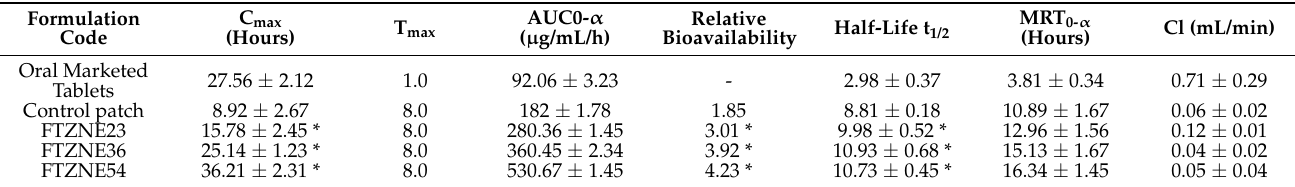
Table A7. Pharmacokinetic parameters of Tizanidine administered orally and transdermal on rabbits, n = 3, mean ± S.D. Formulation